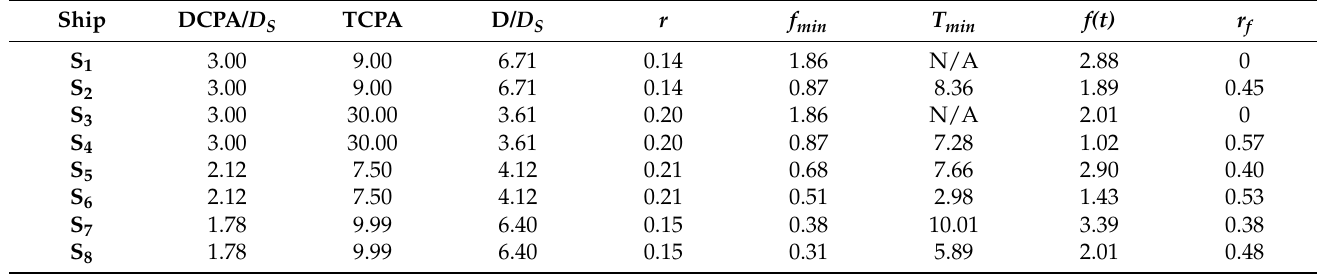
Table 4. Ship collision risk based on r f and r .